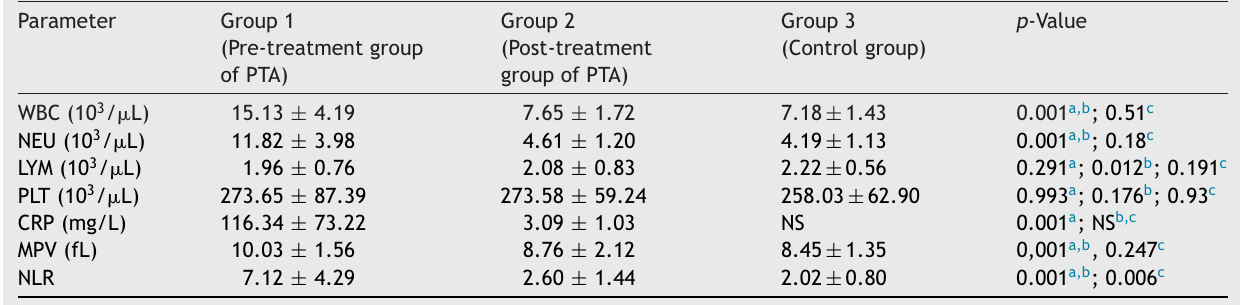
Table 1 Hemogram test results and the MPV, NLR and PLR values of the pre-treatment and post-treatment patients and the controls.